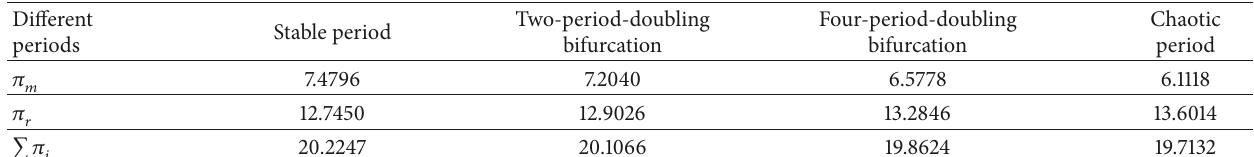
Table 1: Profits when the system is at different times.